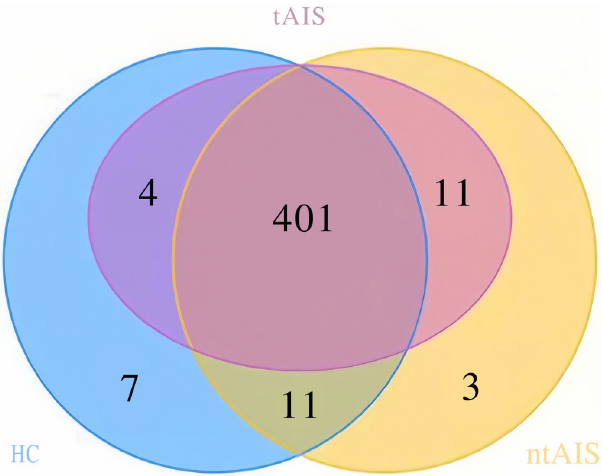
Fig 1. Venn diagram showing OTU similarities and differences among three